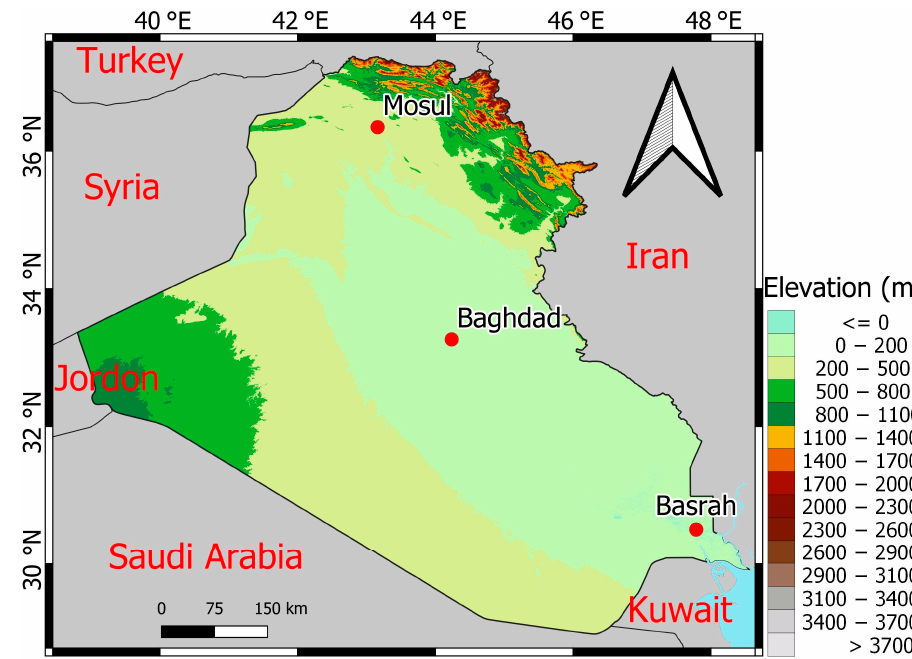
Figure 1. Topography of the study region.